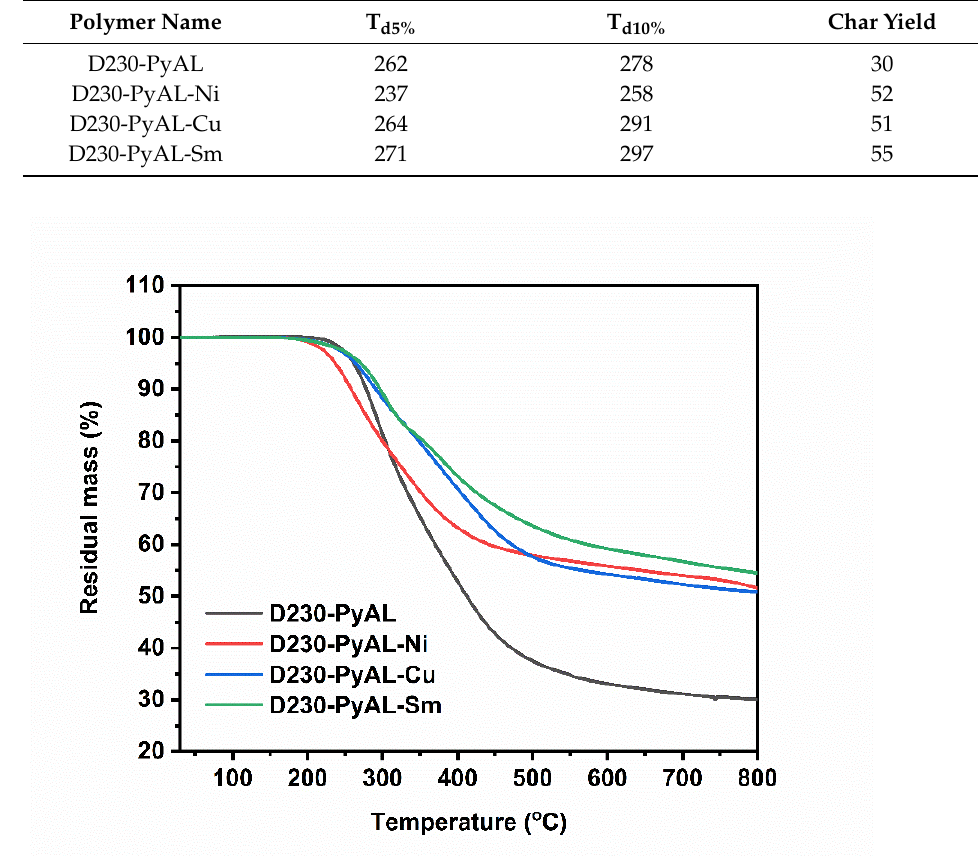
Figure 6. TGA images of polymers and coordination polymers.